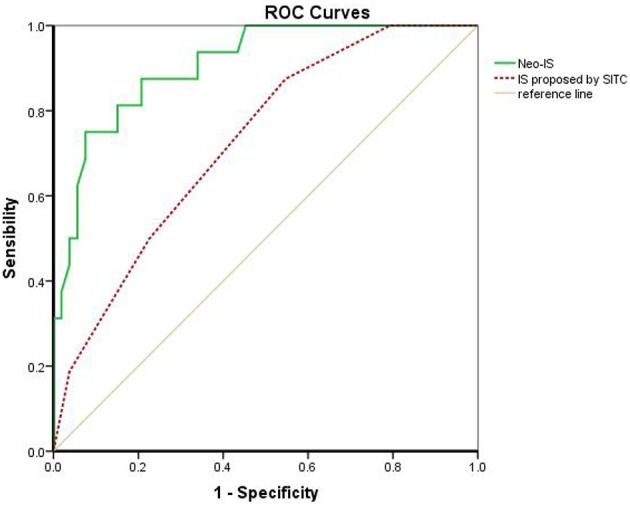
Comparison of the IS proposed by the SITC and the neo-IS. IS proposed by SITC calculated with CD3 and CD8 by CT/ IM. Neo-IS = 0.021 × CD3CT+ density−0.116 × CD4+Foxp3+CD45ROCT+ density−0.038 × CD8+PD-1IM.+ Density.